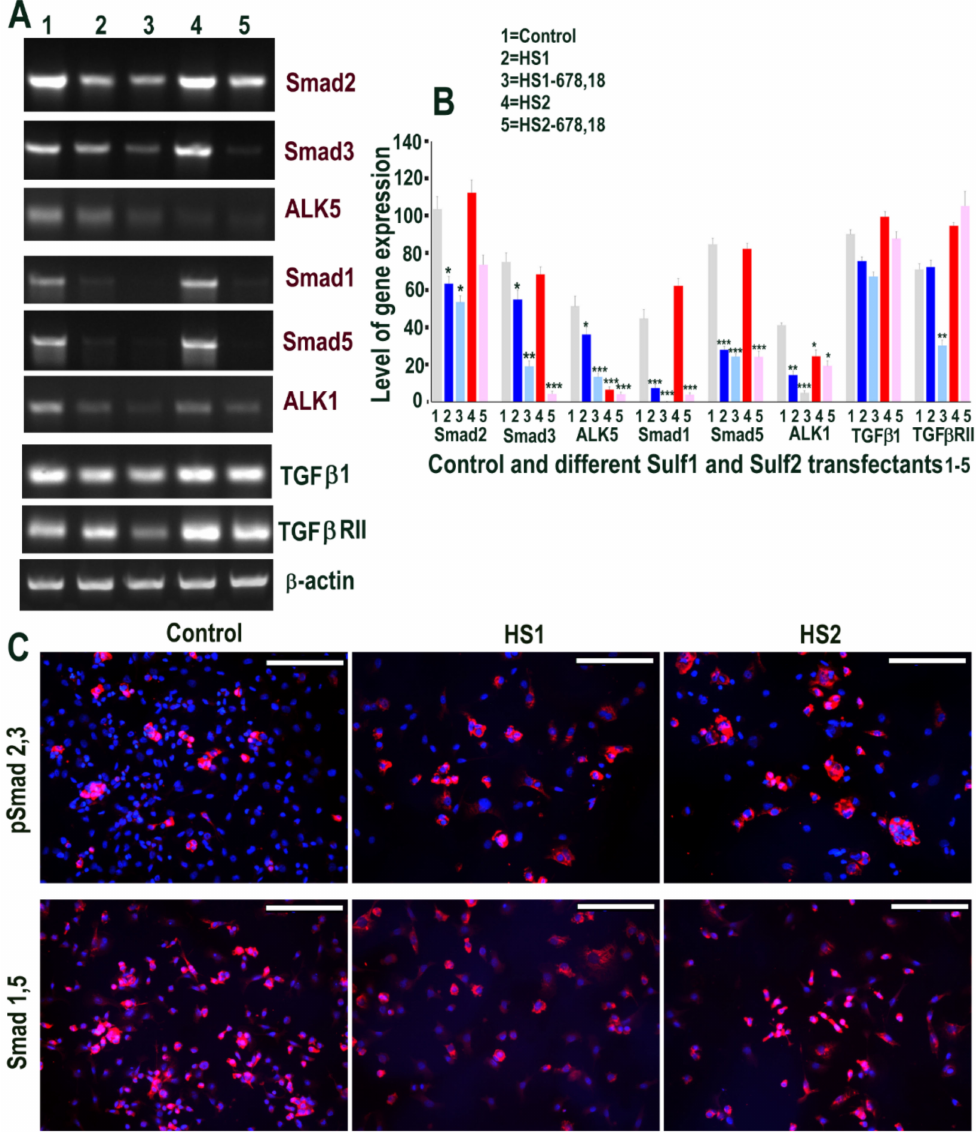
Figure 7. ( A , B ) Some changes in levels of TGF β & BMP cell signalling following transfections of HMec1 cells with (1) pcDNA3, (2) full length Sulf1 (HS1) and (3) shorter inactive Sulf1 (HS1-678,18), (4) full length Sulf2 (HS2) and shorter inactive Sulf2 (HS2-678,18) examined by RT PCR analysis quantified using image J analysis. Error bars = means ± SD; *** p < 0.0001; ** p < 0.001; * p < 0.01. ( C ) Changes in TGF β & BMP cell signalling following control, Sulf1 and Sulf2 transfections confirmed by immunostaining with phosphor Smad2,3 and Smad1,5 antibodies. Scale bar: 100 µ